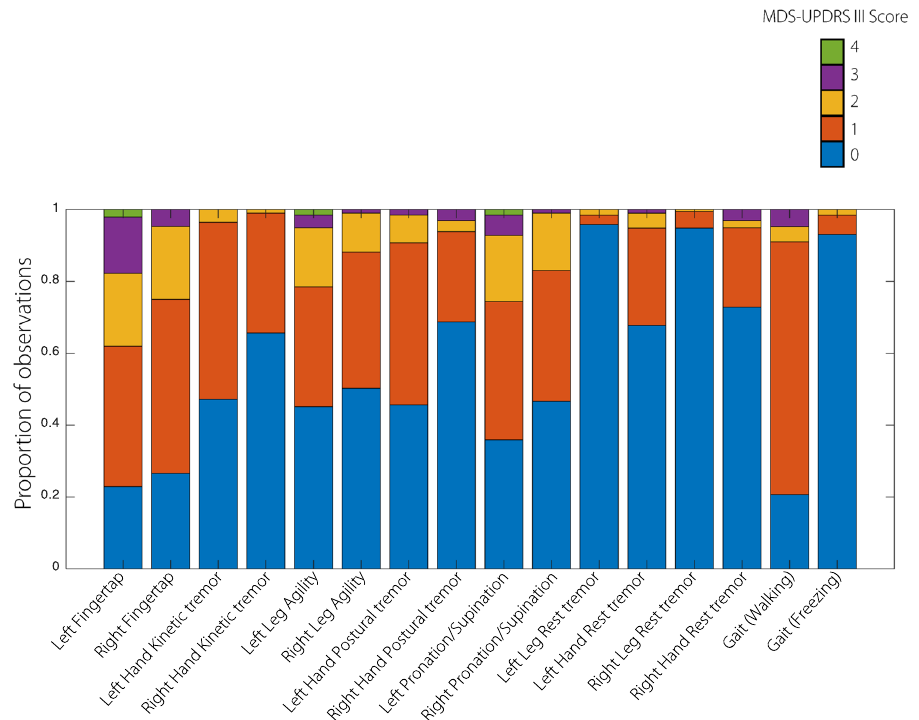
Fig. 1 Clinical MDS-UPDRS III score subitem distributions. Distributions show a skew towards lower values consistent with other studies of early and moderate disease. Some clinical features (notably Left and Right Leg Tremor) show poor variation within this sample of 60 individuals with Parkinson ’